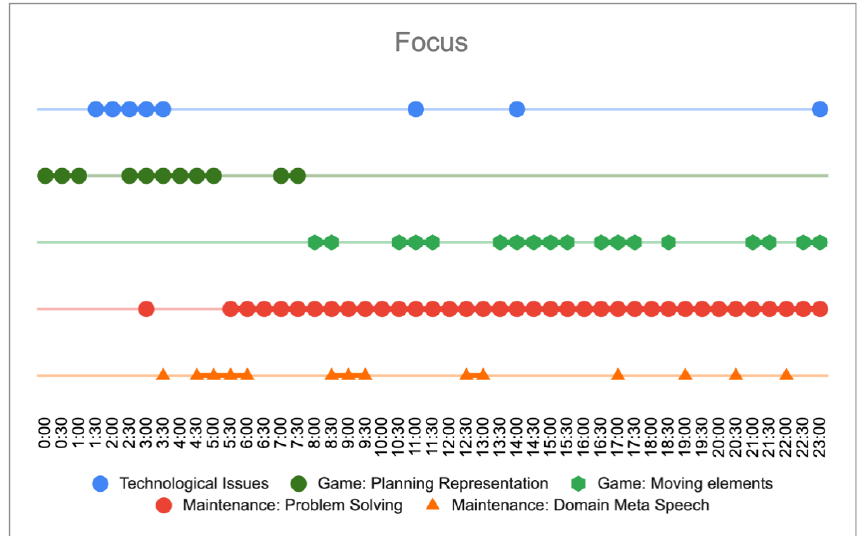
Figure 3. Focus of conversation during stage